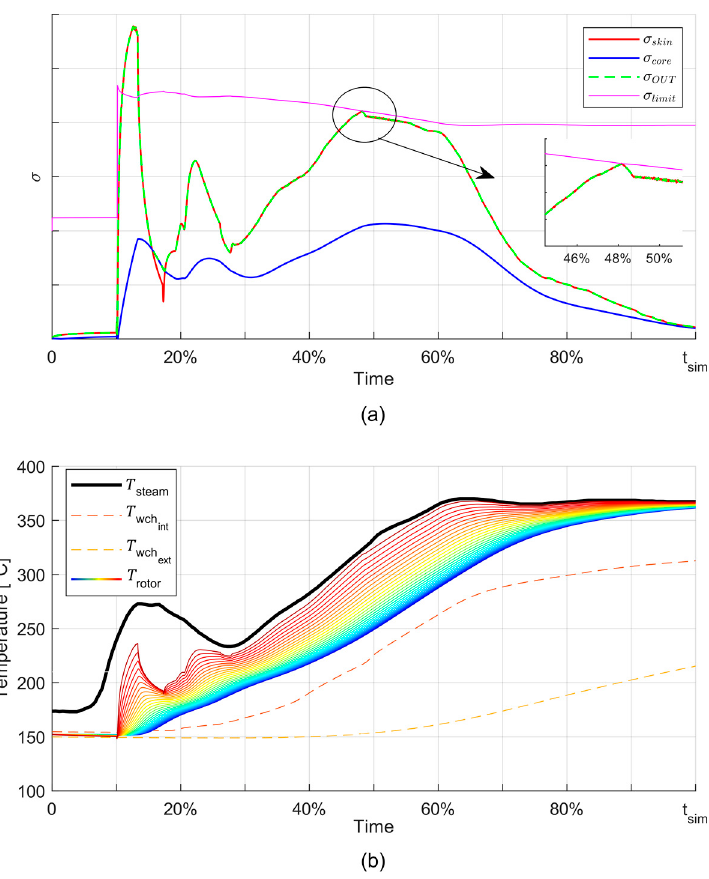
Figure 12. PI controller test, stress trend, and temperatures. Stress trends ( a ); temperature of the steam, wheel chamber and rotor ( b );